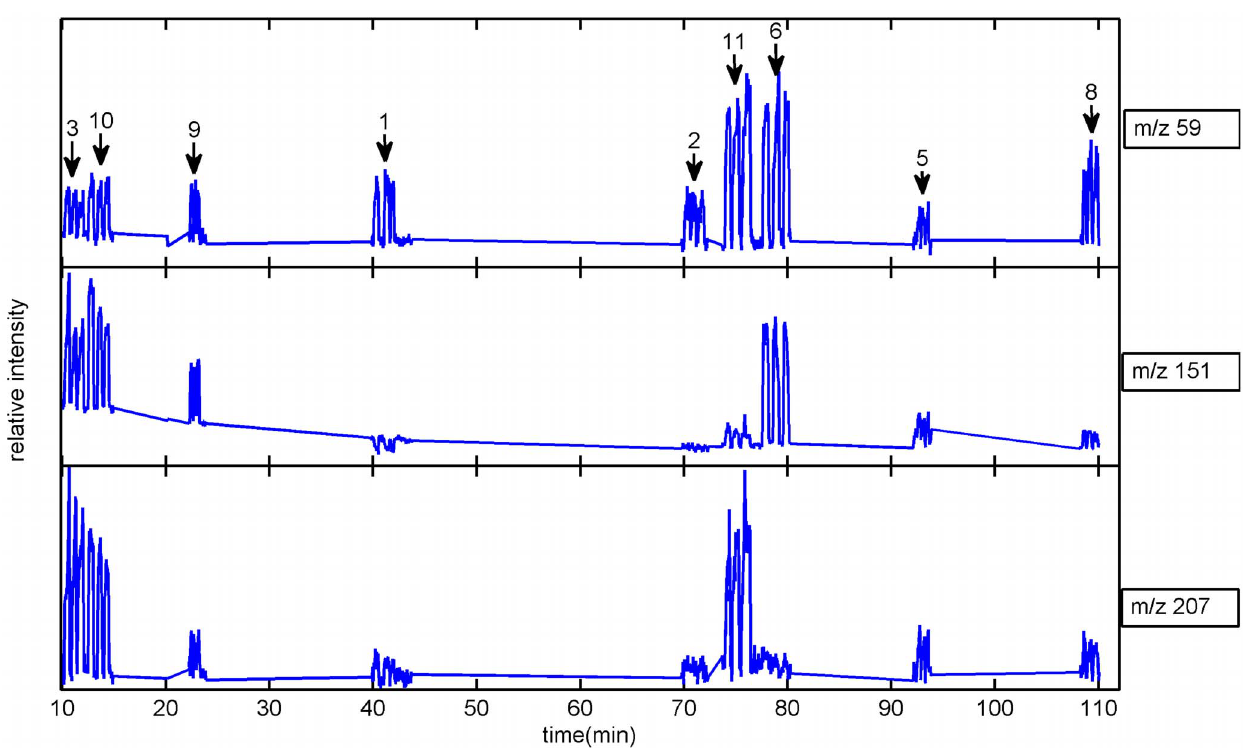
Figure 1. Real-time analysis allows for the rapid breathprinting of subjects. During the 1.5 hours experiment shown above, nine subjects breathed into the mass spectrometer. The subjects’ label codes are indicated at the top of each of the three replicate measurements in the top trace. The three traces correspond to the ion intensity as a function of time for m/z 59, 151 and 207. Each subject breathed in triplicate, which is illustrated by the three steps of the signal above the background per subject. This snapshot already illustrates the high inter-subject breathprint